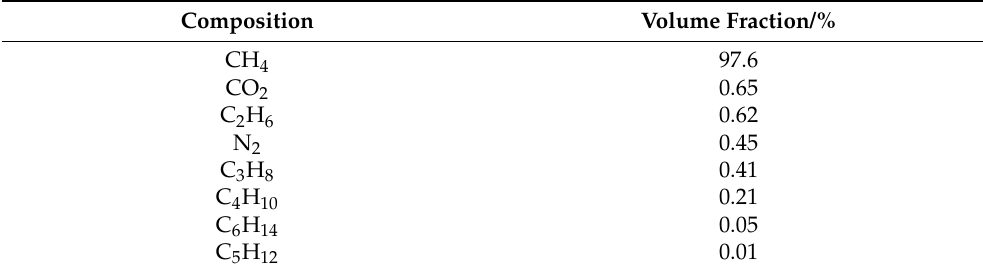
Table 1. Fuel Table 1. Fuel components.